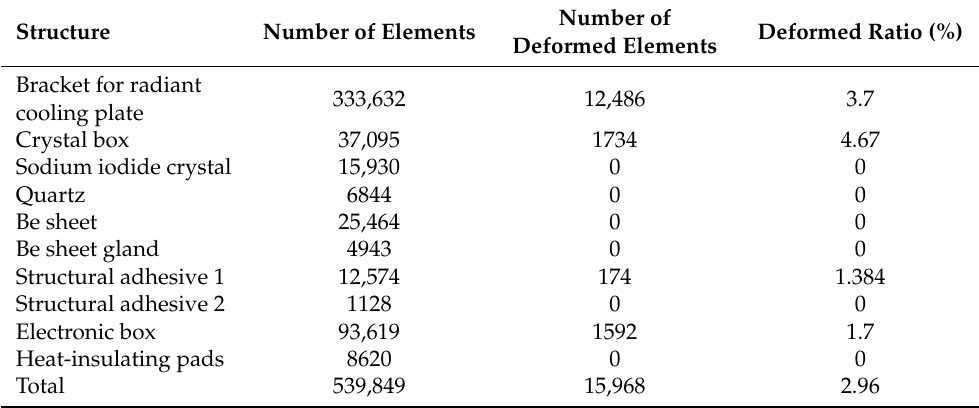
Figure 3. Finite element model. Table 1. Model element information.